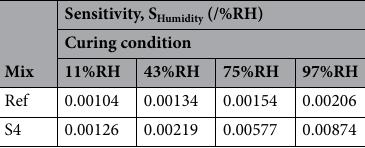
Table 3. Calculated sensitivity of reference and S4 samples exposed to 11%, 43%, 75% and 97%